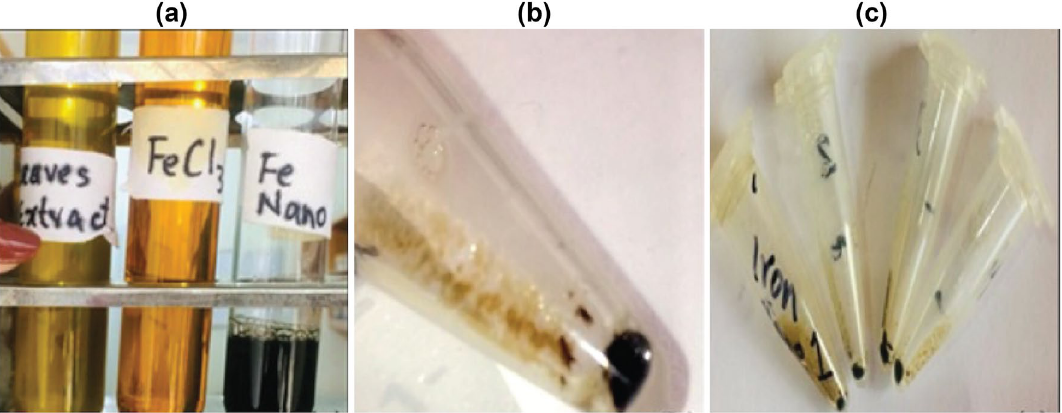
Figure 1. Preparation of GINPs. ( a ) Green tea leave extract, 0.1 M FeCl 3 solution, and iron nanoparticles. ( b , c ) synthesized iron-nanoparticles pellet after centrifugation